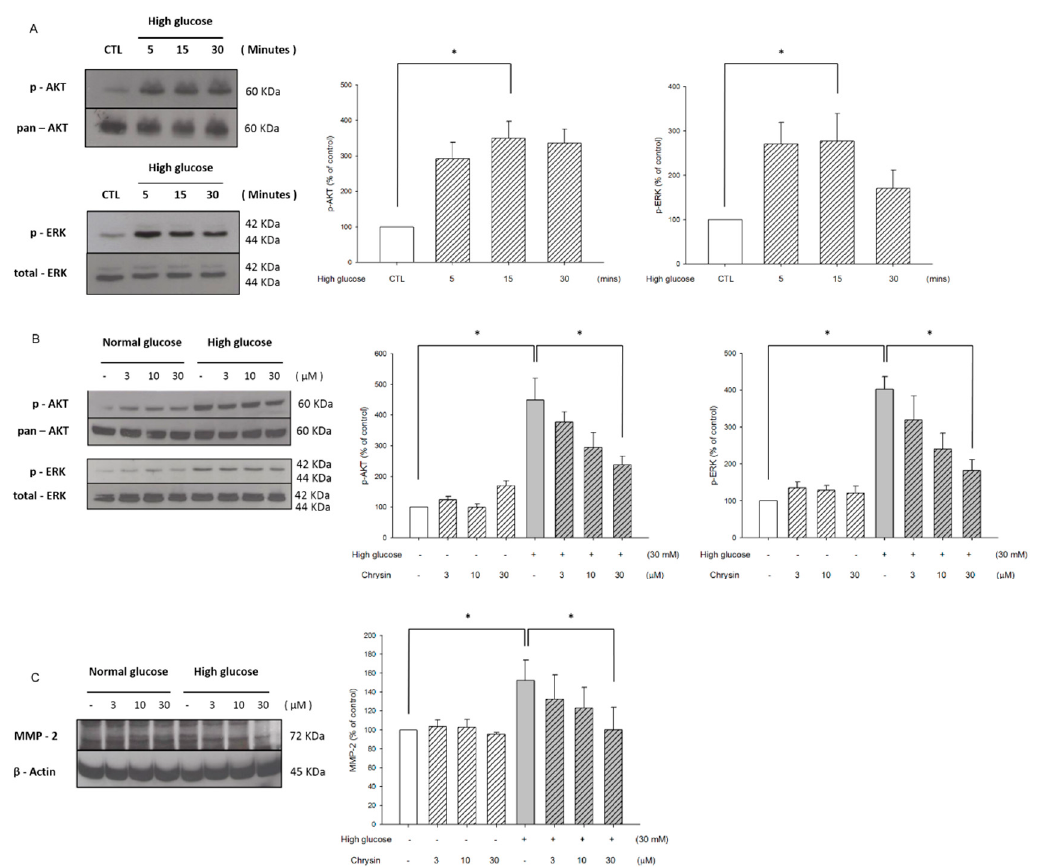
Figure 5. Chrysin inhibited AKT and ERK phosphorylation and decreasing MMP-2 expression. ( A ) The time course for high glucose up-regulated AKT and ERK phosphorylation. RF / 6A cells were cultured in a high glucose medium (30 mM) and harvested at di ff erent time points (5, 15, 30 min). Subsequently, the western blot analysis was performed for the phosphorylation of AKT and ERK. The quantification data is shown on the right panel. ( B ) Chrysin down-regulated AKT and ERK phosphorylation induced by high glucose. RF / 6A cells were treated with chrysin and then harvested after changing high glucose for 15 min. A western blot analysis was performed for the phosphorylation of AKT and ERK. The quantification data is shown on the right panel. ( C ) Chrysin suppressed MMP-2 expression levels induced by high glucose with the quantification data being shown on the right panel. All data was acquired by means of ± SE from at least three independent experiments. * p < 0.05, vs. control.